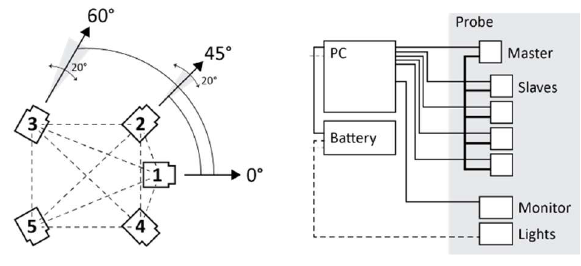
Figure 3 . Schematic of the multi-camera rig (left), and schematic of the device